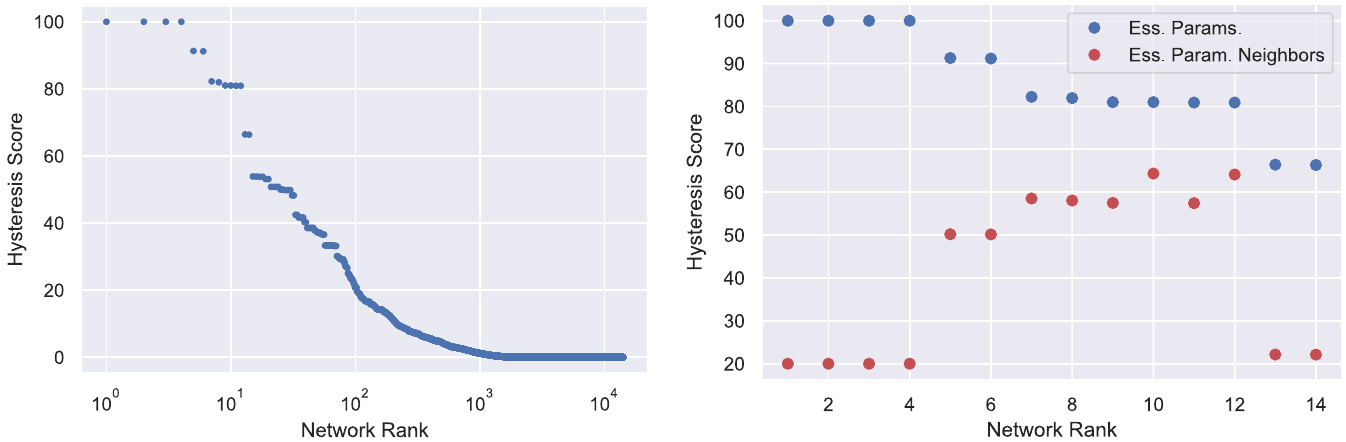
Fig 8. Left: 14,098 three node networks ranked by (descending) hysteresis score analyzed at the essential parameters. Right: The top scoring networks are further discriminated by scoring hysteresis in a neighborhood of the essential parameters. The scores after perturbation are shown in (red) and the scores at essential parameters in (blue).